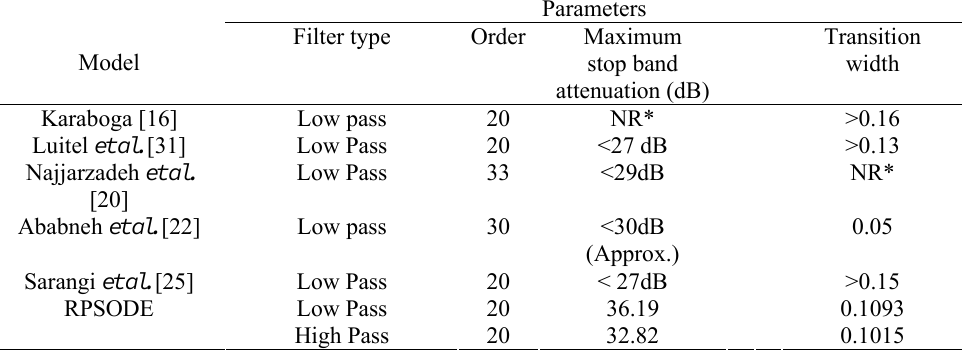
Table 5. Compariosn of RPSODE with other reported